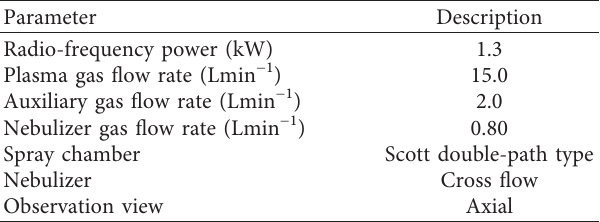
Table 2: Operational conditions for ICP-OES.